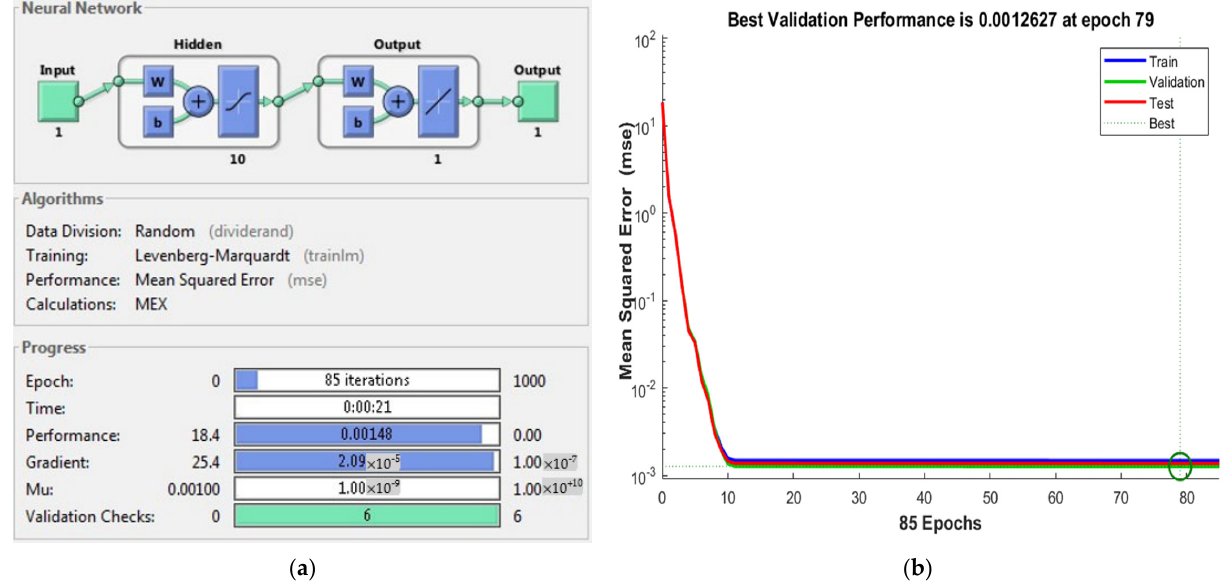
Figure 10. ANN architecture of the torque controller and its evolution formation ( a ) Performance of the mean quadratic error (training, testing, validation) ( b ).